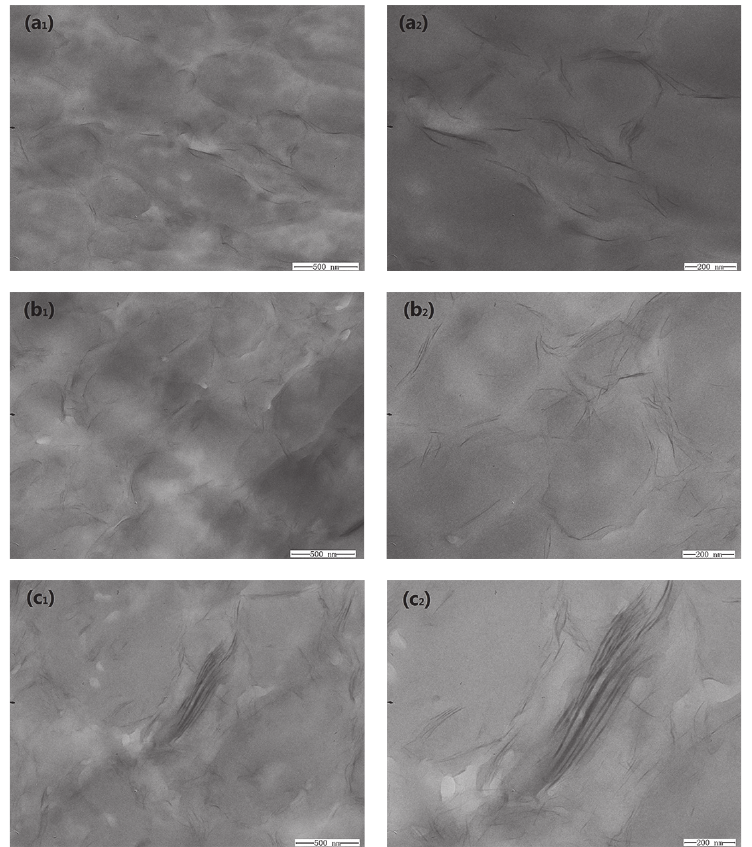
Figure 2: TEM micrographs of PPO/PA66 nanocomposites: (a 1 ) N-2; (a 2 ) high magnification of (a 1 ); (b 1 ) N-4; (b 2 ) high magnification of